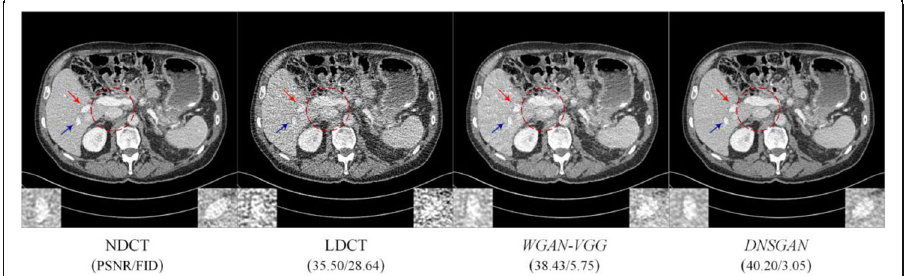
Fig. 1 The restoration results from WGAN-VGG and proposed DNSGAN . Red and blue arrows denote the zoomed ROI regions, the circle denotes finer local structures. DNSGAN outperforms WGAN-VGG in sharpness and